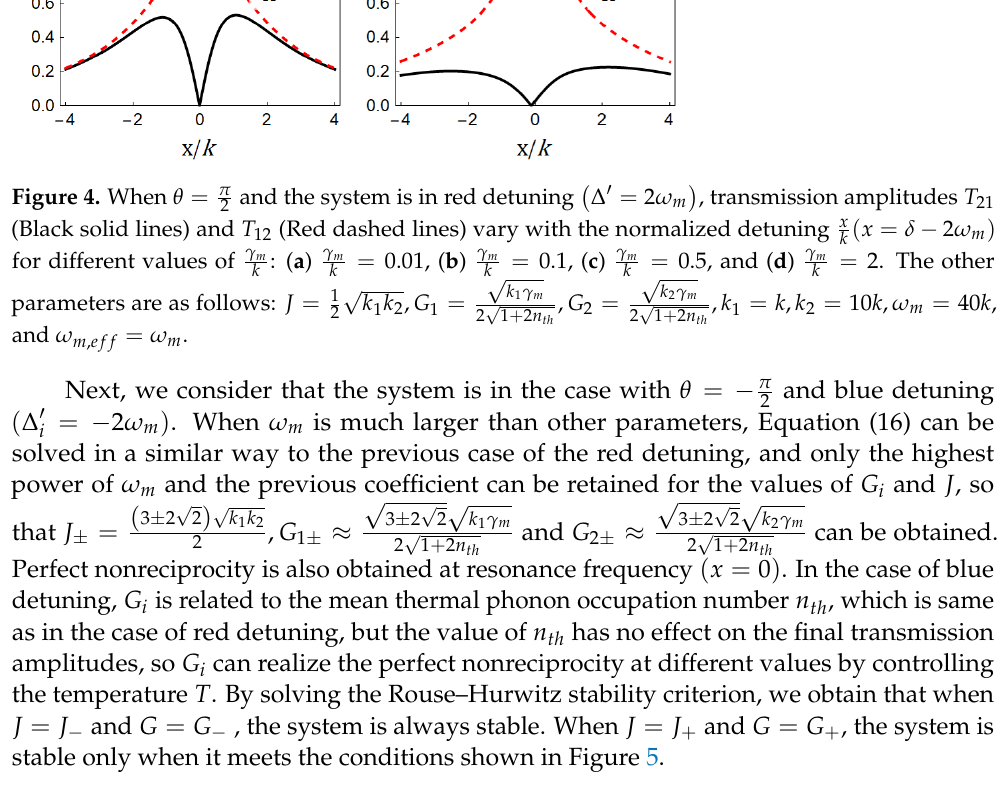
Figure 5. A stability diagram of the system versus (cid:1863) and (cid:2011) (cid:3040) . The used parameters are (cid:2016) (cid:3404) (cid:3398) (cid:3095) (cid:2870) , Δ (cid:3036)(cid:4593) (cid:3404) (cid:3398)2(cid:2033) (cid:3040) , (cid:1863) (cid:2869) (cid:3404) (cid:1863) (cid:2870) (cid:3404) (cid:1863), (cid:1836) (cid:3404) (cid:1836) (cid:2878) , (cid:1833) (cid:3404) (cid:1833) (cid:2878) , (cid:2033) (cid:3040) (cid:3404) 40(cid:1863) , and (cid:2033) (cid:3040),(cid:3032)(cid:3033)(cid:3033) (cid:3404) (cid:2033) (cid:3040) .